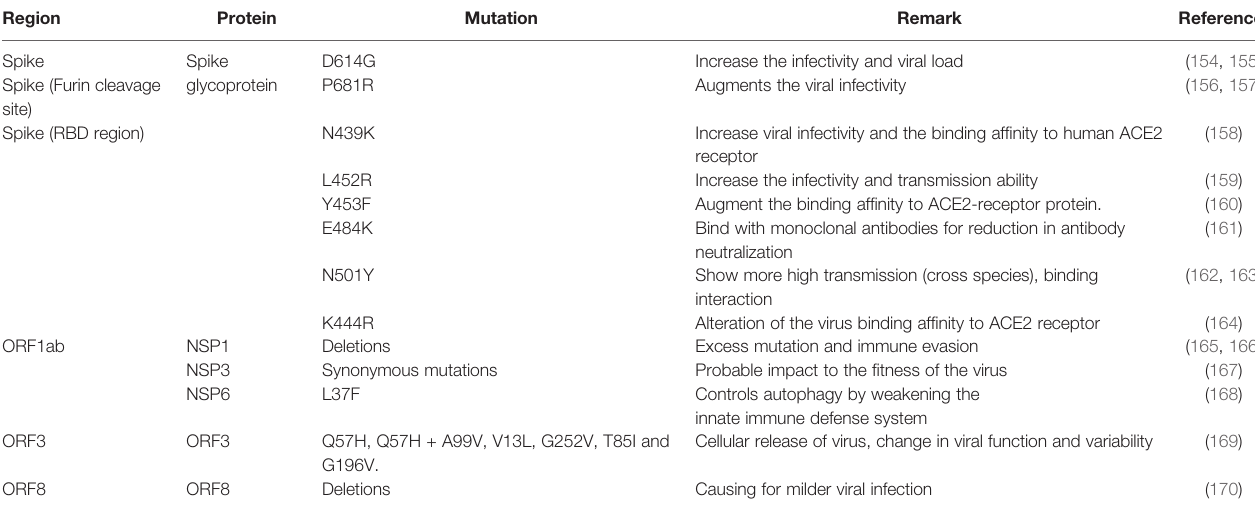
TABLE 2 | Signi fi cat mutations are noted in different regions of the SARS-CoV-2 variants, which helps in immune escape.